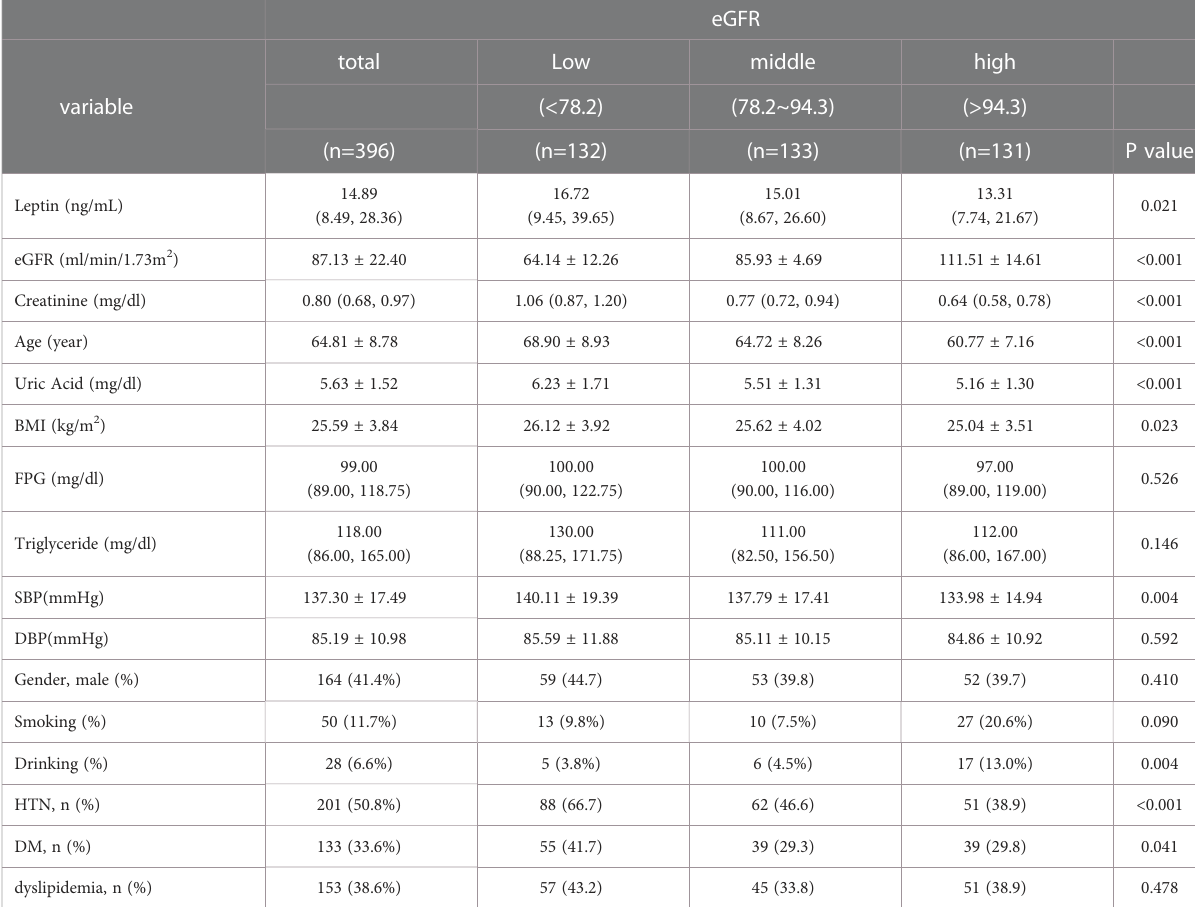
TABLE 1 General characteristics of the study population according to tertiles of